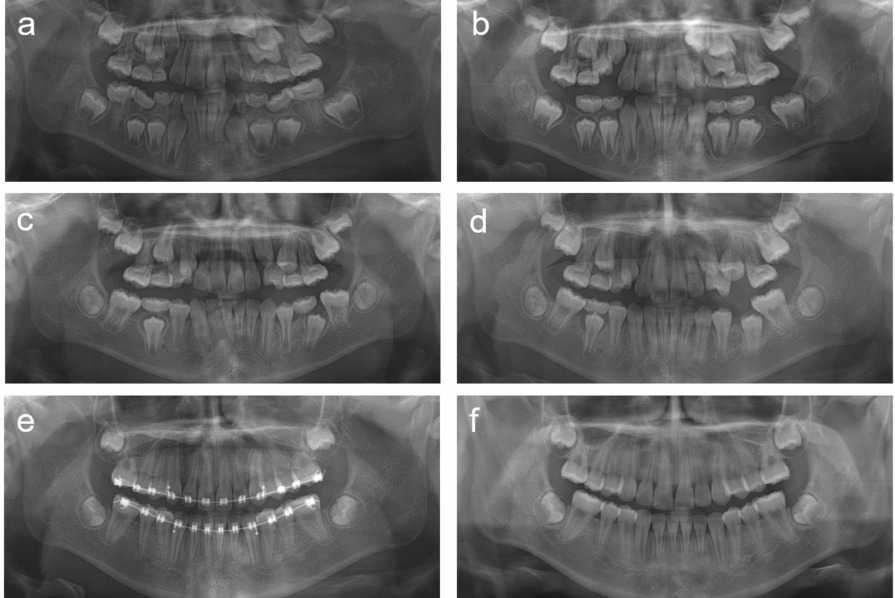
Figure 8. Panoramic radiographs of patient 5. ( a ) Panoramic radiograph at age 8 years 10 months. ( b ) Panoramic radiograph at age 9 years 8 months. ( c ) Panoramic radiograph at age 10 years 9 months. ( d ) Panoramic radiograph at age 11 years 2 months. ( e ) Panoramic radiograph at age 12 years 11 months. ( f ) Panoramic radiograph at age 14 years 1